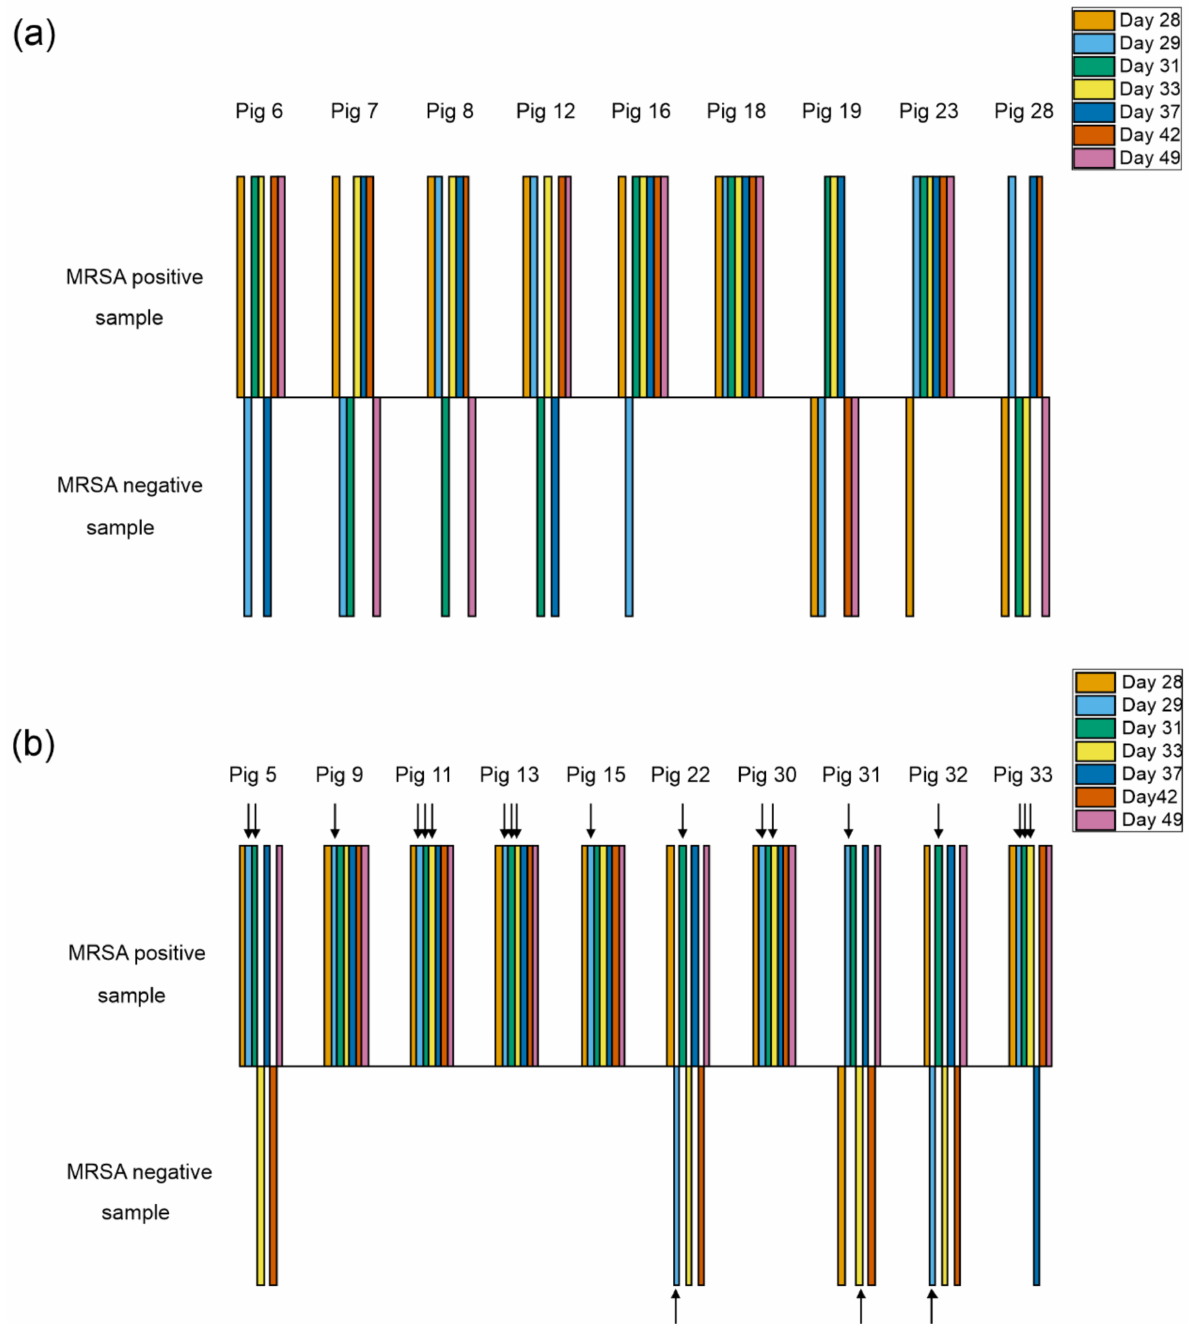
Figure 2. The distribution of MRSA and phage in the nasal and swab samples during the experiment. The results from the control group ( a ) and phage group ( b ) are shown. Bars above and below the line indicate MRSA positive and negative samples, respectively. An animal was considered positive if MRSA was detected in either nasal swab sample at a given time point. The black arrows indicate positive phage findings in the same